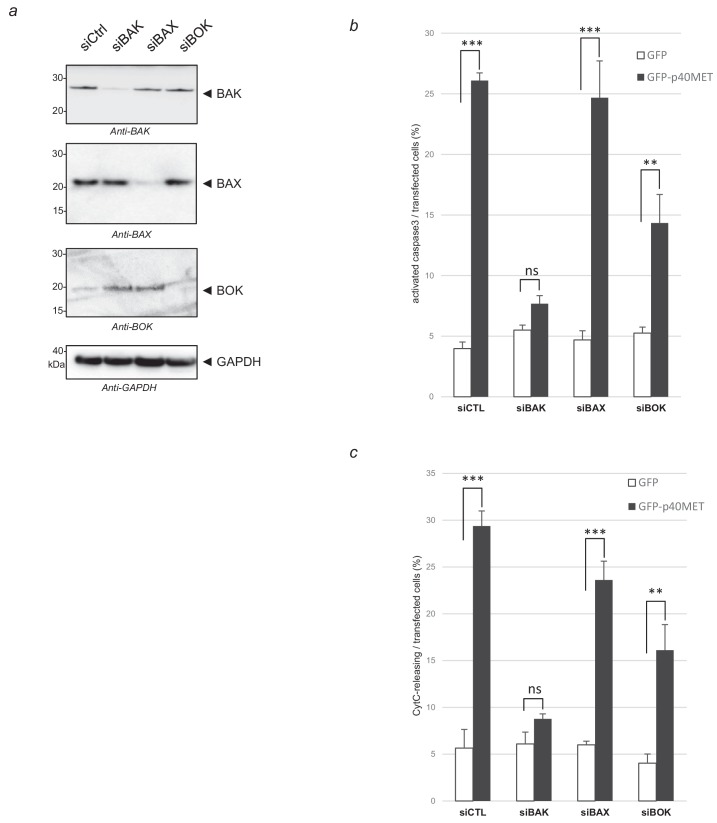
Effect of BAK, BAX and BOK silencing on p40MET-induced apoptosis in MCF10A cells.One day before transfection with a vector expressing either GFP or GFP-p40MET, MCF10A cells cultured on 12 well plates were transfected with a control siRNA or with siRNA targeting either BAK, BAX or BOK and treated with zVAD (20 µM) when analyzed next for cytochrome C release. Twenty four hours later for MCF10A, (a) one part of the cells was lysed and extracts were analyzed by western blotting with antibodies against BAK, BAX, BOK and GAPDH. (b, c) In parallel, immunofluorescence staining was performed with an anti-cleaved caspase 3 or anti-cytochrome C antibodies and nuclei were labeled with Hoechst. The percentage of cytochrome C release or of cleaved-caspase-3-positive cells was determined with respect to the number of GFP-positive cells. At least 100 cells were counted per well (n = 3;± S.D.). ns, nonsignificant; **, p<0.01; ***, p<0.001 as determined by Student’s t test.Figure 2—figure supplement 1—source data 1.Source data of Figure 2—figure supplement 1b–c reporting counting of GFP, active caspase 3, and cytochrome C release positive cells, calculation of the percentage, mean and SD, diagram conception and statistical analyses.